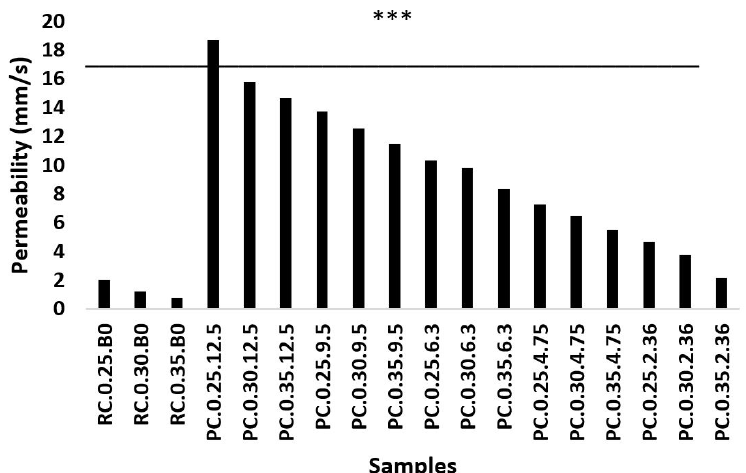
Figure 6 A verage samples results of permeability tests. *** Statistically significant difference by the Tukey test p